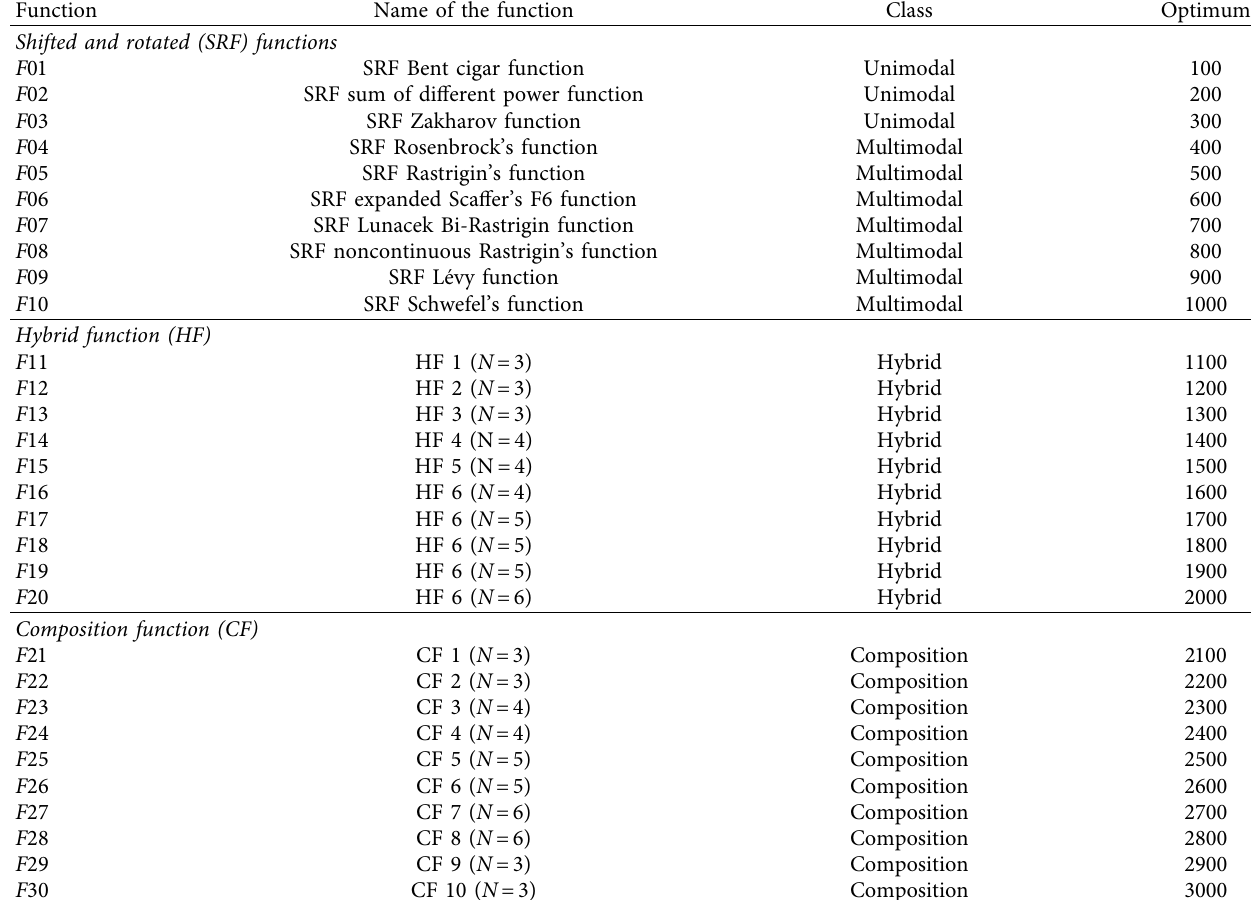
Table 3: CEC2017 benchmark